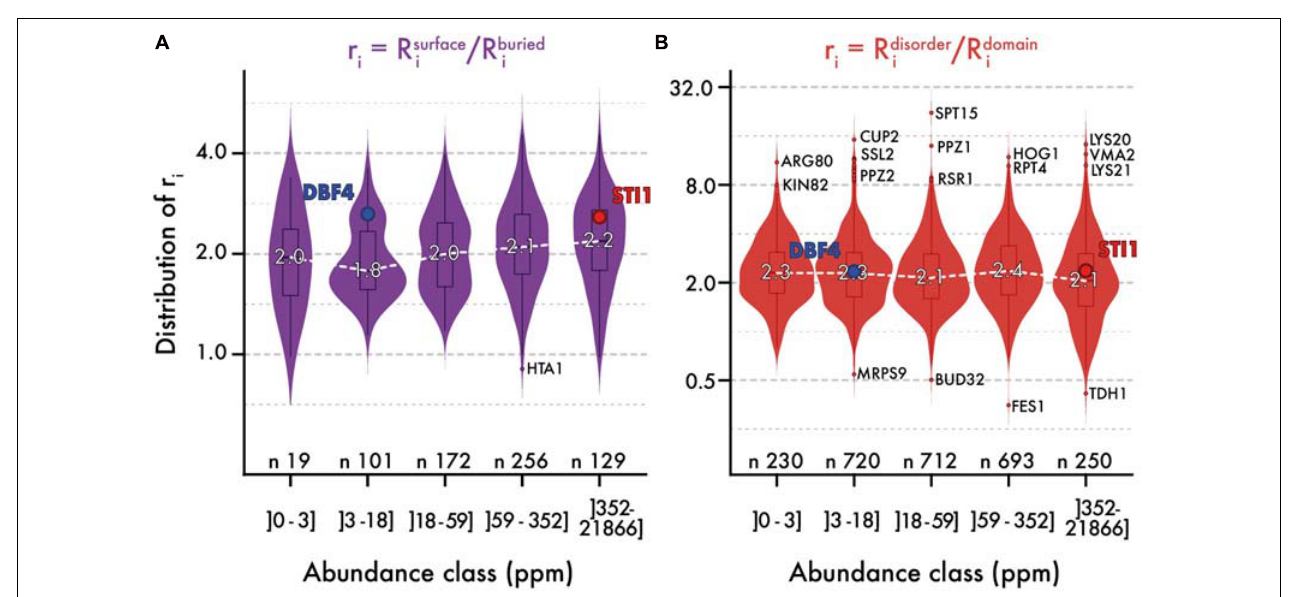
FIGURE 3 | The relative evolutionary rates of different protein regions are steady with abundance. Distribution of evolutionary rates ratio between different regions in the sequence ( y -axis), across five classes of protein abundance ( x -axis). A ratio is calculated by dividing the average evolutionary rate of residues found in two regions panel (A) surface vs. buried, panel (B) disorder vs. domain. The white dashed line highlights the median ratio across bins of abundance. Overlaid box plots show the interquartile range (IQR = 25 to 75% quantiles) with their whiskers extending to 1.58 × IQR. Beyond this interval, the three most extreme outlier values are annotated. The number of proteins contributing to each distribution is given. We also highlight the relative rates for a pair of proteins, one with low and one with high abundance (STI1 and DBF4). These two proteins show comparable structural features, different evolutionary rates (respectively, 0.575 and 1.34 for their full sequence), and similar